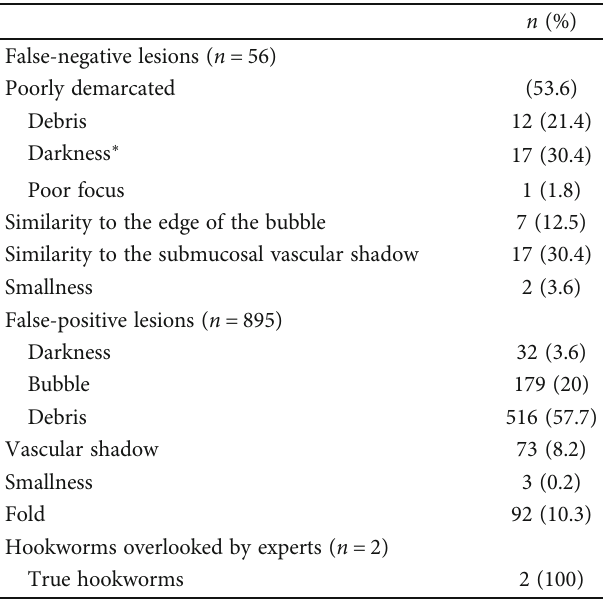
Figure 4: The receiver operating characteristic curve of the convolutional neural network for detecting hookworms. AUC: area under the curve; CI: con fi dence